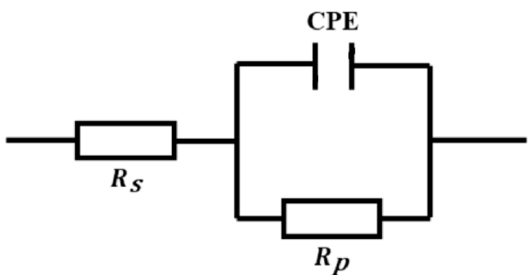
Figure 7. Electrochemical equivalent circuit model used to fit and simulate the impedance data.